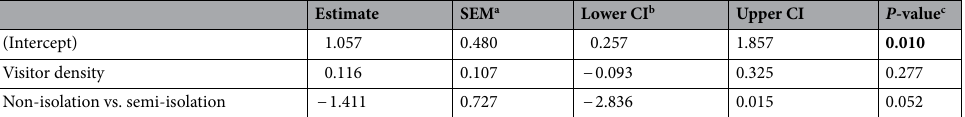
Table 2. Effects of visitor density and social isolation on the distance between gibbons (model 1). *Visitor density (original mean ± SD = 3.38 ± 6.11); the reference level of the isolation phase is “non-isolation.” a SEM standard error of the mean. b CI confidence interval. c P -values in bold are significant.